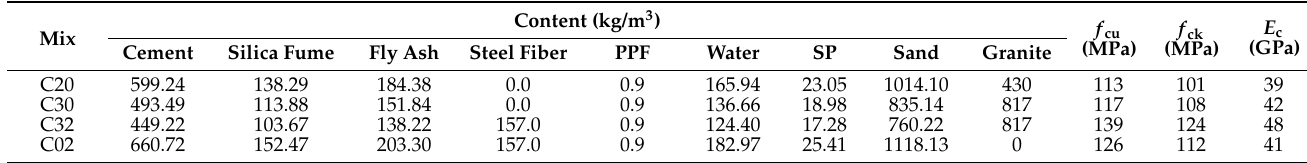
Table 3. Mix proportions and mechanical properties of CA-UHPC.